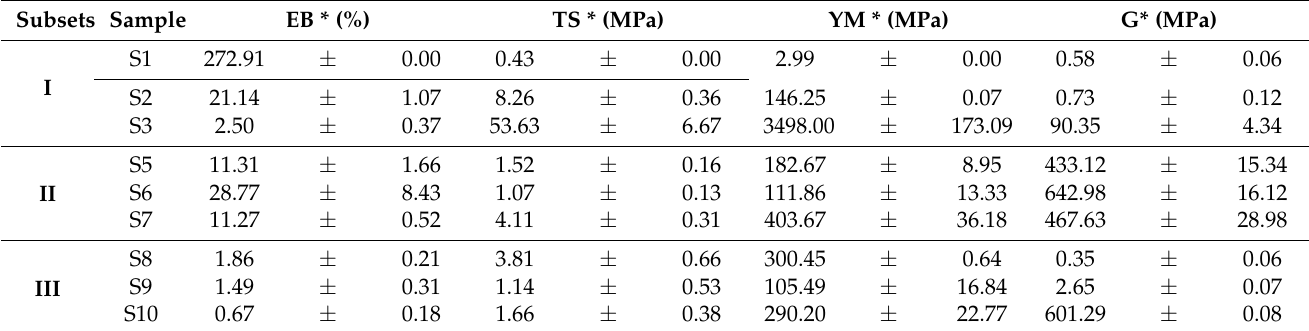
Table 4. Mechanical properties of the investigated printing